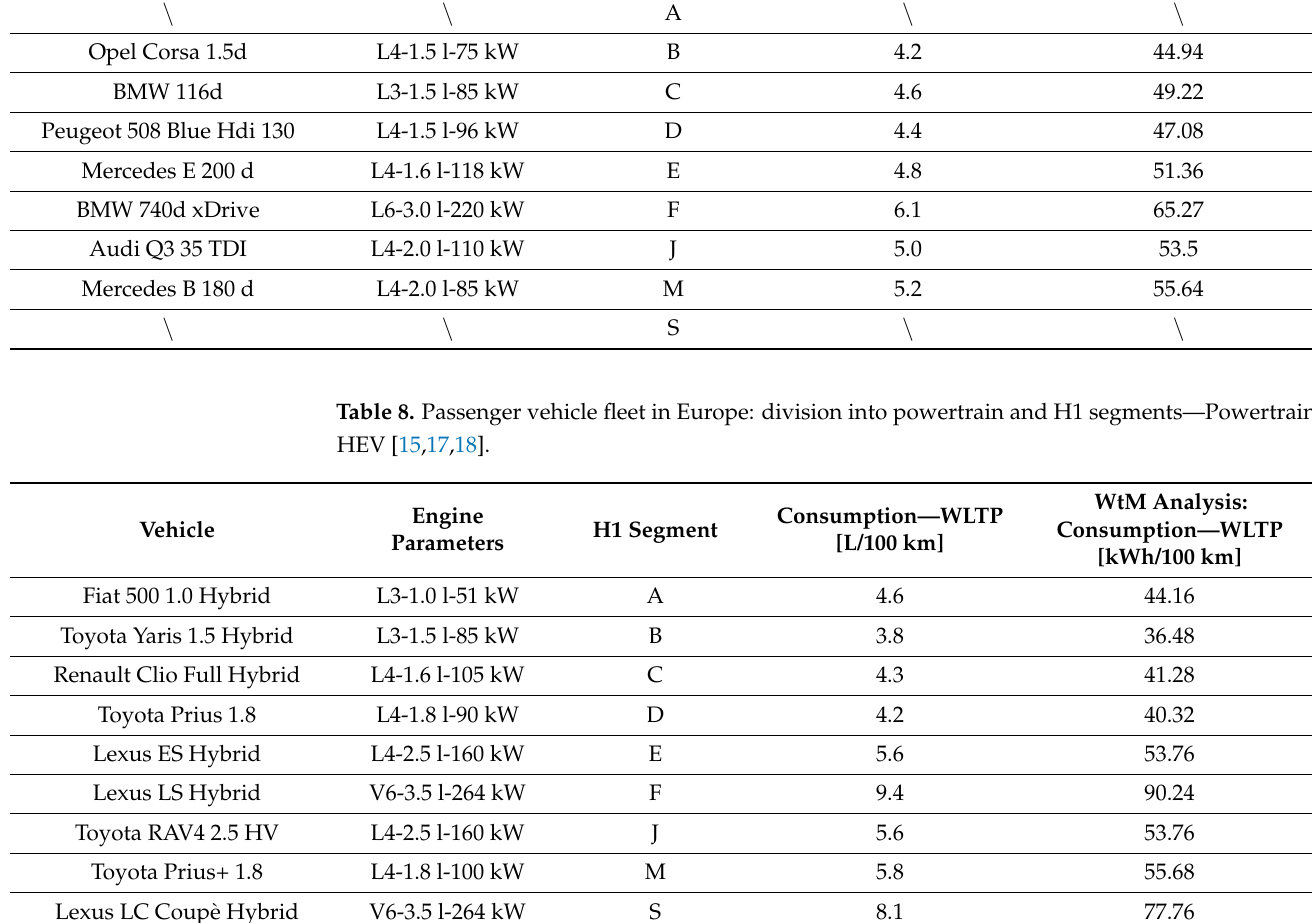
Table 7. Passenger vehicle fleet in Europe: division into powertrain and H1 segments—Powertrain: ICEV fed by diesel [15,17,18].